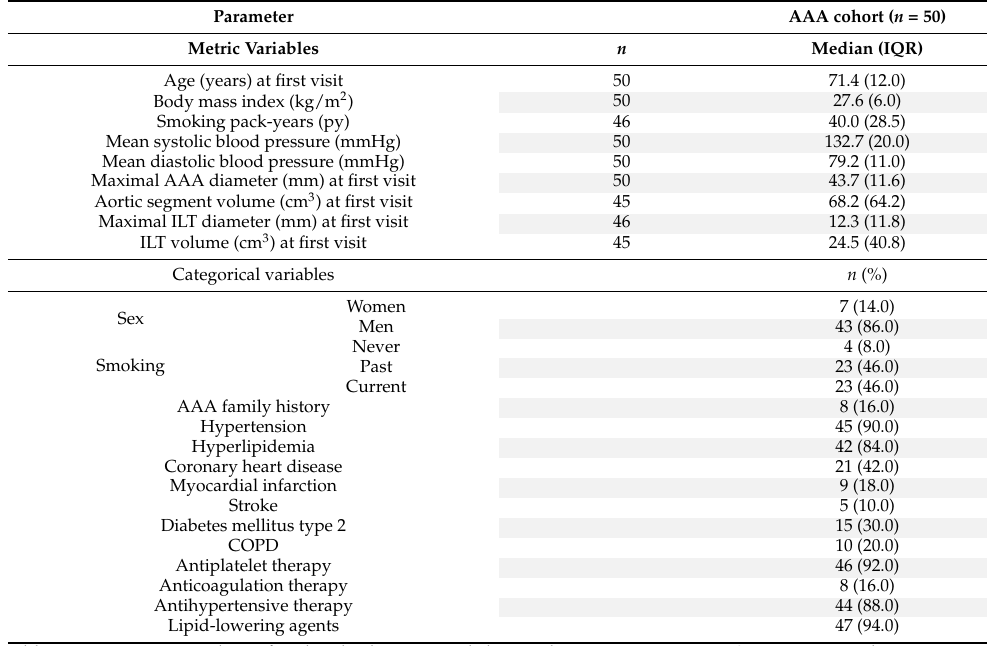
Table 2. Demographics of AAA patients in the prognostic